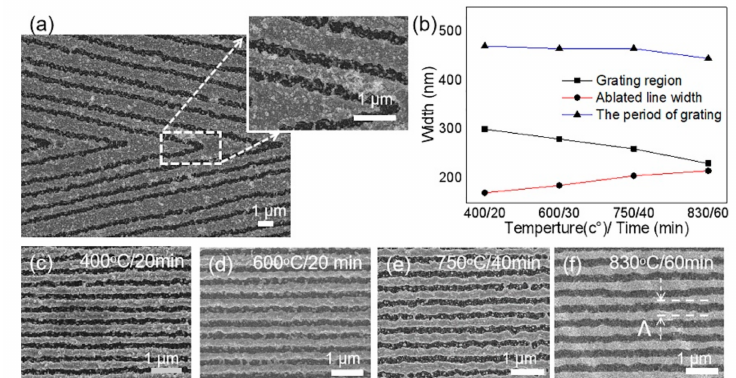
Figure 2. Femtosecond-laser direct ablation of blazed grating at di ff erent annealing temperatures and time. ( a ) SEM image of the fabricated dielectric gradient optical elements without annealing; ( b ) ablated line width and the periods of grating vs temperatures and time and their corresponding SEM images ( c – f ). Scale bars denote 1 µ m.